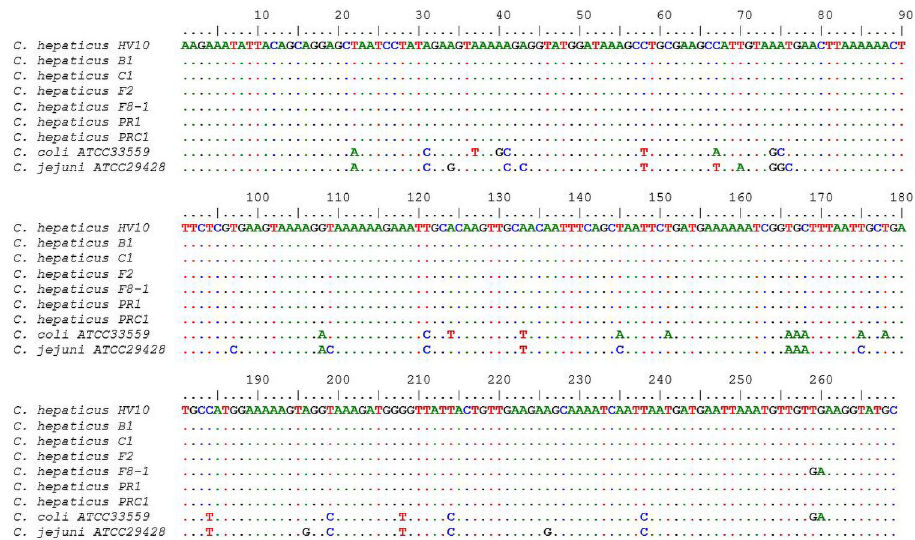
Fig 4. Alignment of nucleotide sequences ( hsp60 gene) of selected Campylobacter isolates using CLUSTAL W. Identical nucleotides and deletions are shown by ‘.’ and ‘-’, respectively.